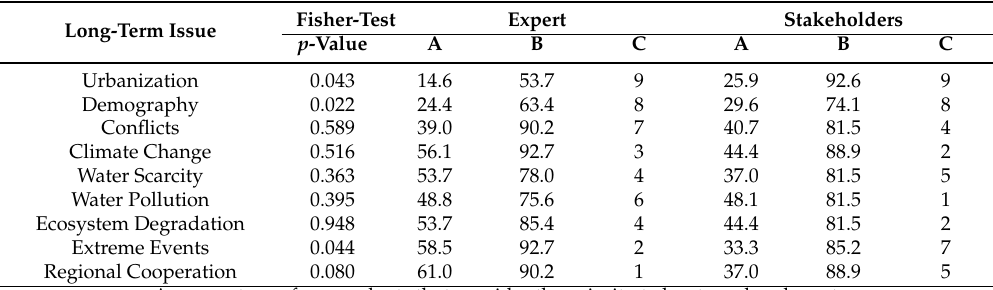
Table 2. Long-term issues: Expert versus stakeholder points of